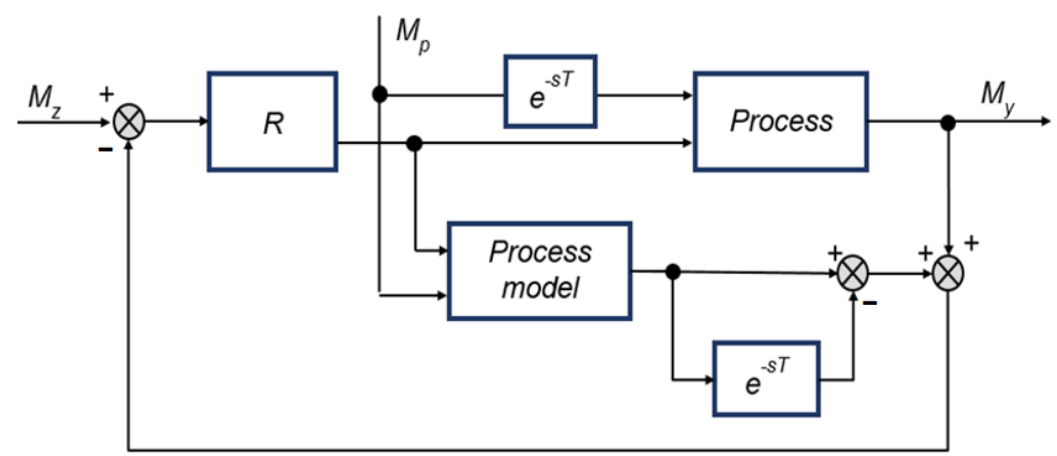
Figure 6. Control system diagram [22]: M z —set value of the transported product weight (kg), M p —sum of degrees of opening the discharge flaps in the jig (%), M y —current weight of transported heavy product (kg).